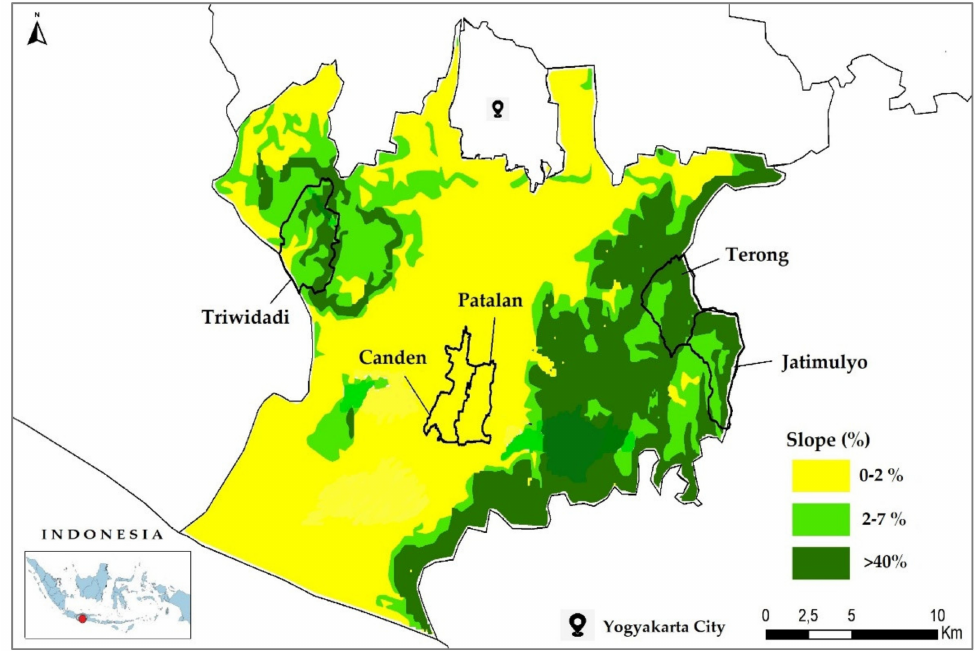
Figure 1. Bantul District with topographic information (slope gradient) and observed